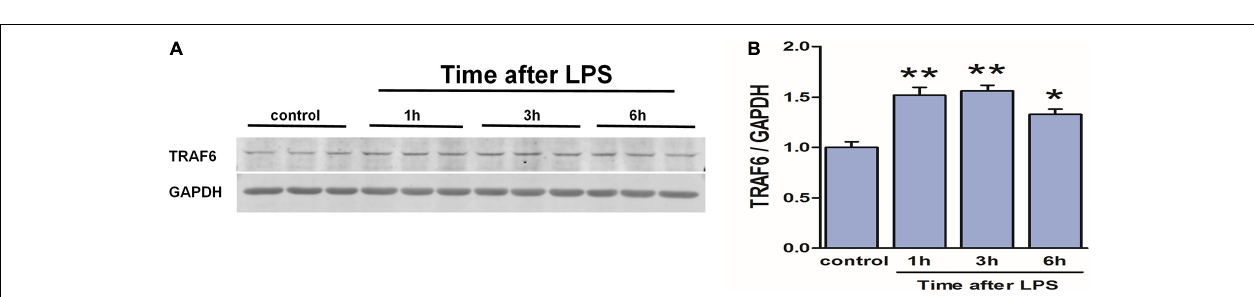
appear to mediate upregulation of CCL2, CCR2, CXCL1, and CXCR2 following